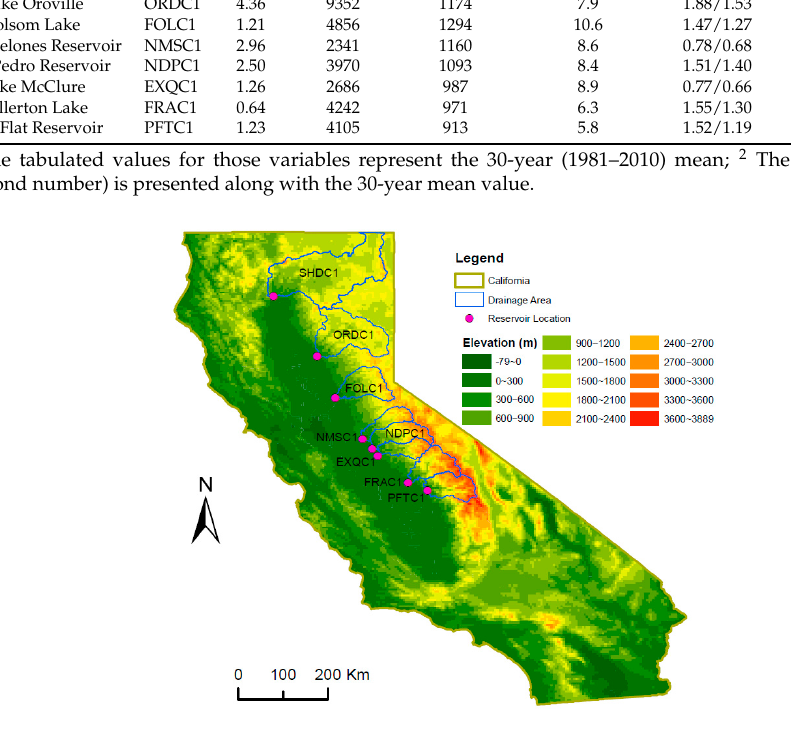
Figure 1. Location map showing study reservoirs and their corresponding drainage areas.